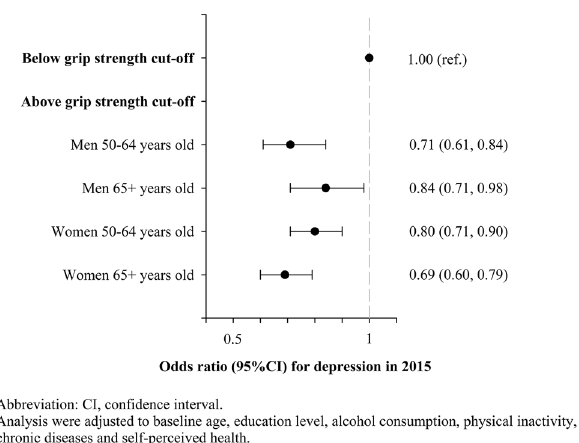
Figure 2. Odds ratio for having depression in 2015 according to being bellow or above the grip strength cut-off value in